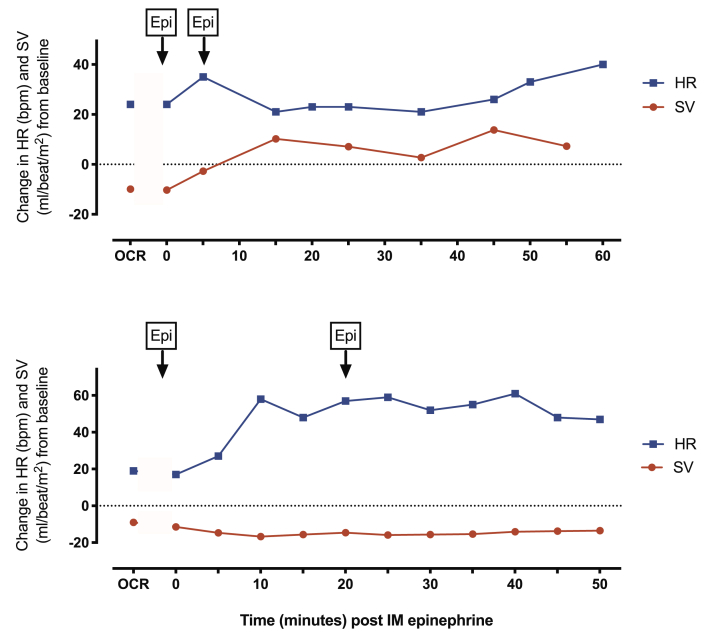
Change in heart rate (HR) and stroke volume (SV) in 2 participants who received 2 doses of IM epinephrine. IM, Intramuscular; OCR, objective clinical reaction.